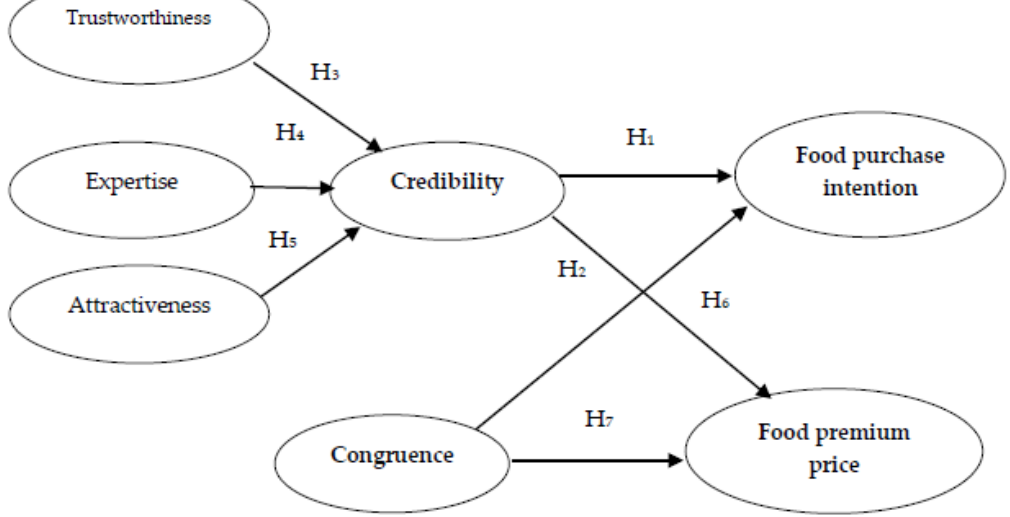
Figure 1. Conceptual model for food purchase intention and willingness to pay a premium price influenced by celebrity endorsement.